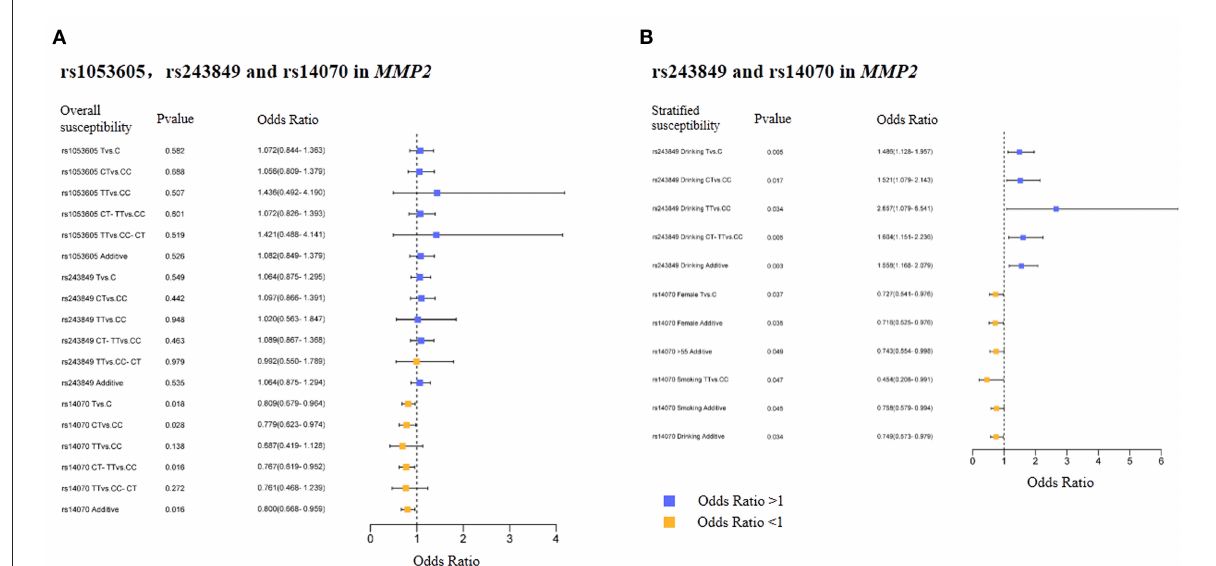
FIGURE1 Overall and stratified analysis results of rs1053605, rs243849 and rs14070 in MMP2 . (A) Overall results of rs1053605, rs243849, and rs14070 in MMP2 . (B) Stratified significant results of rs243849, and rs14070 in MMP2 .